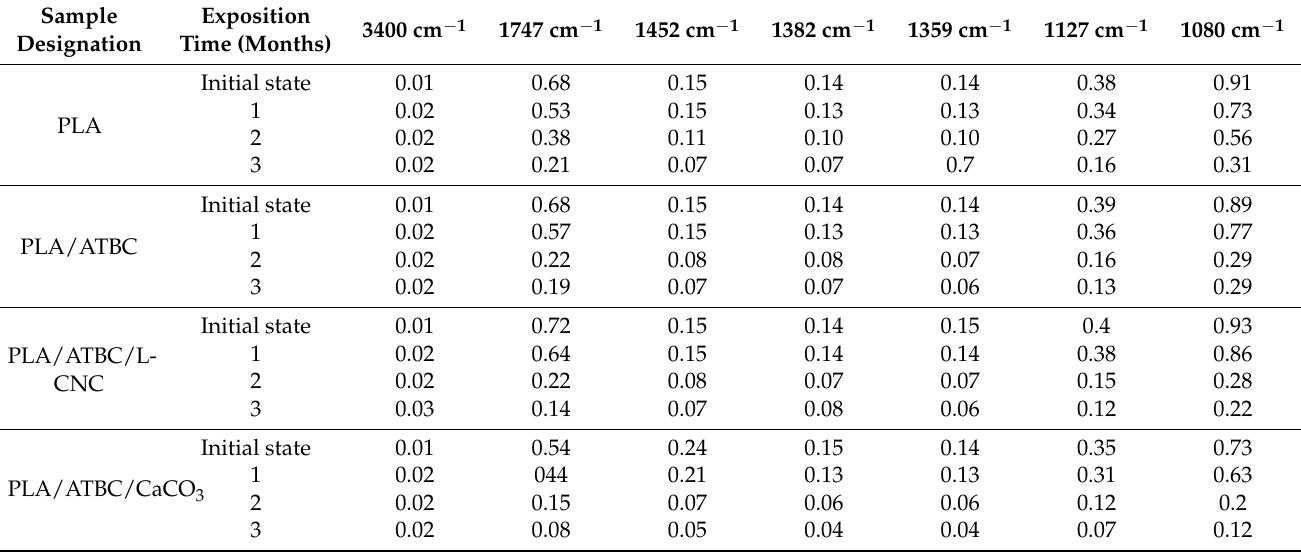
Table 4. Peak intensity of PLA biocomposites exposed to 3 months of biodegradation in freshwater